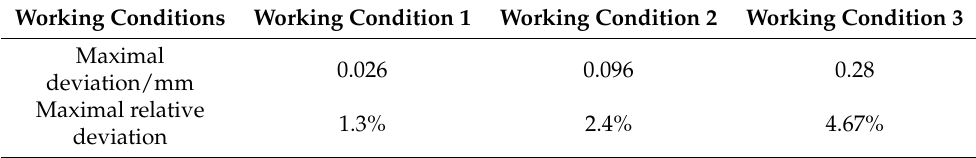
Figure 11. Comparative deviation curves of different PID control methods. Table 4. Control deviation of the adaptive PID control system based on a neural